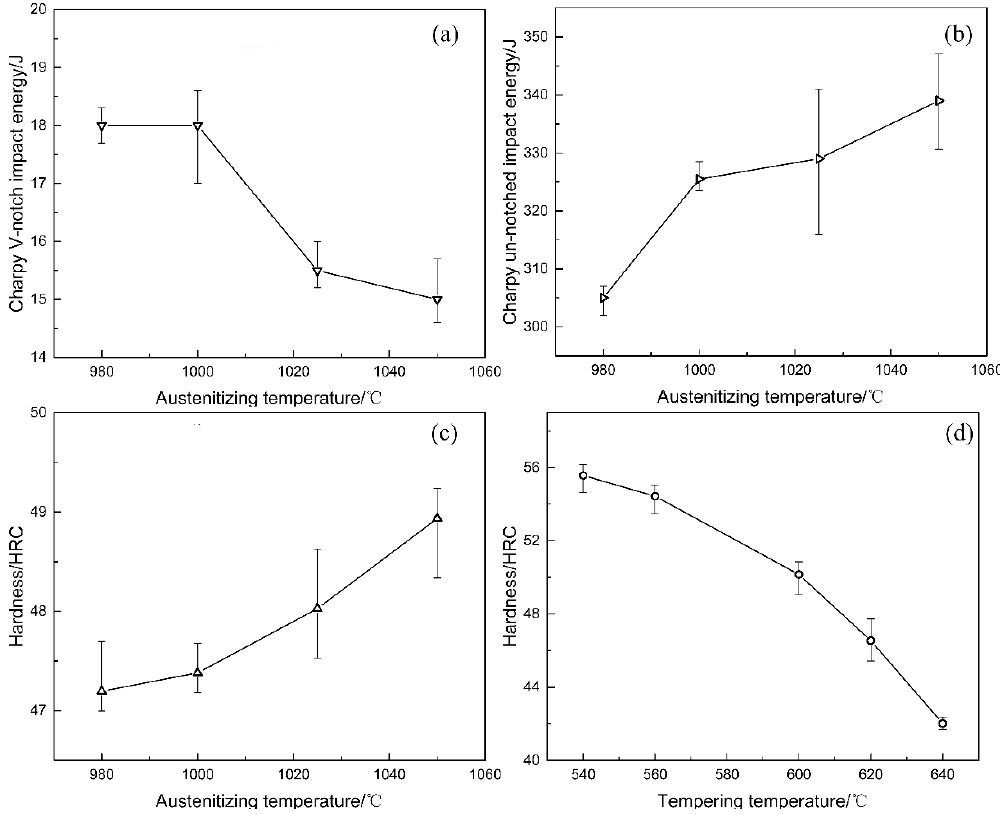
Figure 1. The effect of different austenitizing temperatures on (a) Charpy V–notch impact energy; (b) Charpy un-notched impact energy and (c) hardness; and (d) hardness value as a function of the tempering temperatures of the 5Cr5Mo2 steel with an austenitizing temperatures of 1050 ℃ .